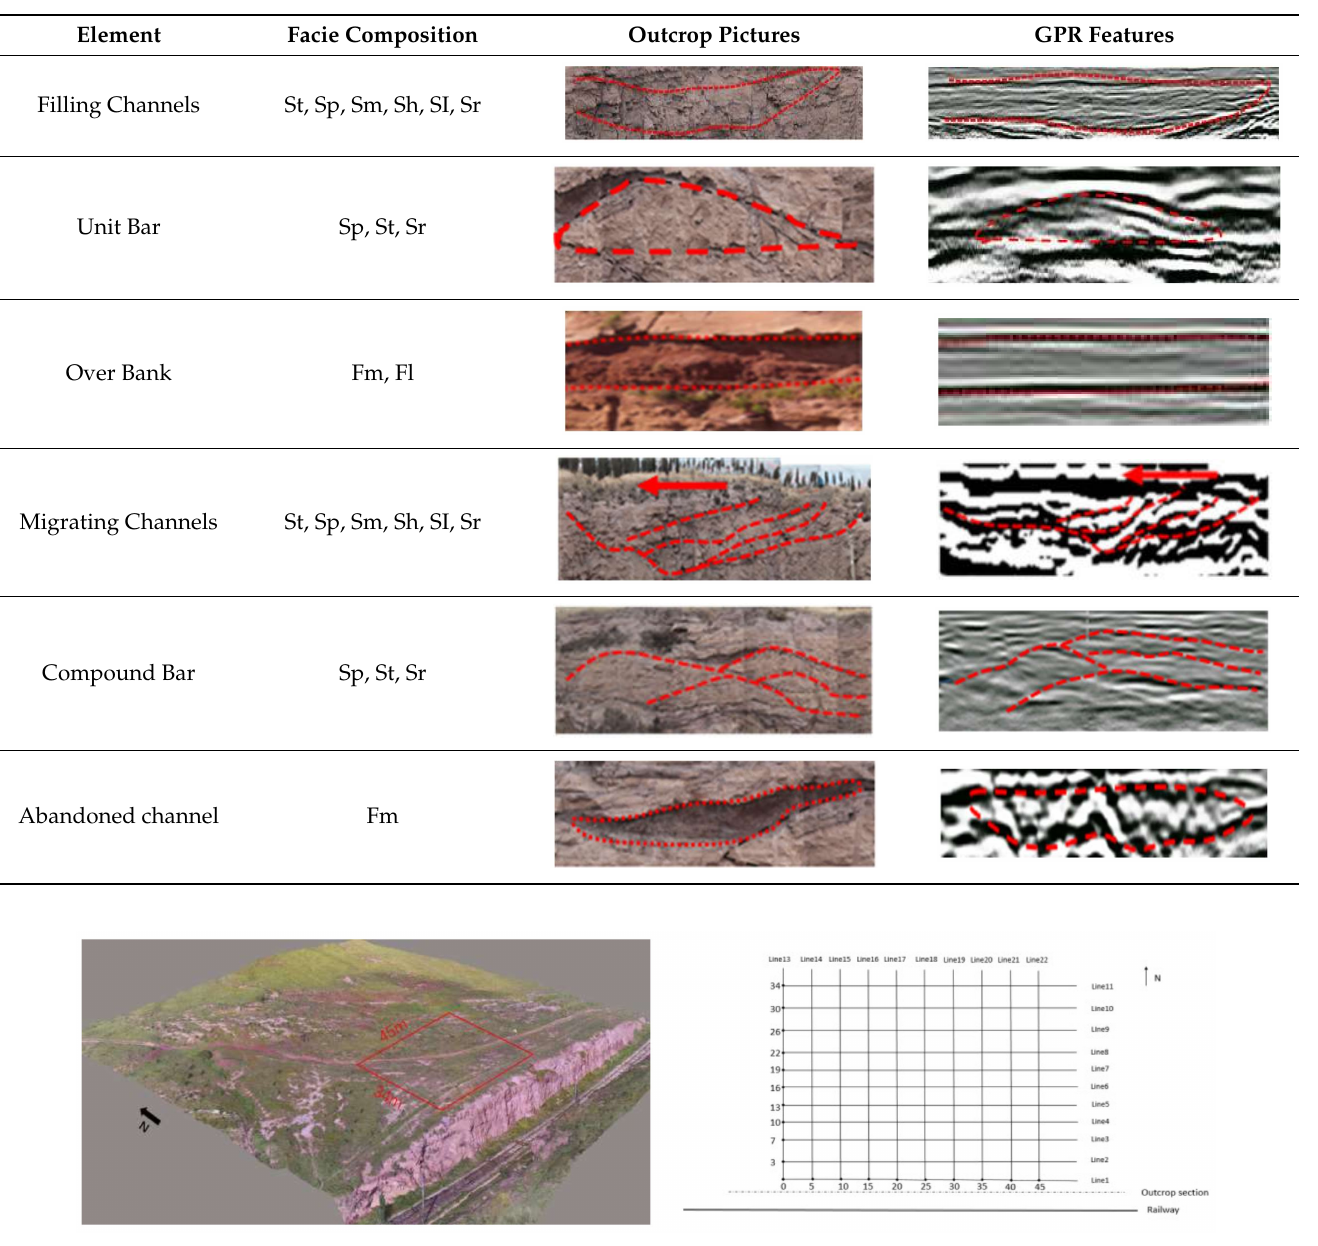
Table 2. Summary of identified sedimentary architectural elements and their GPR characteristics in the Yungang Formation, Datong Basin.